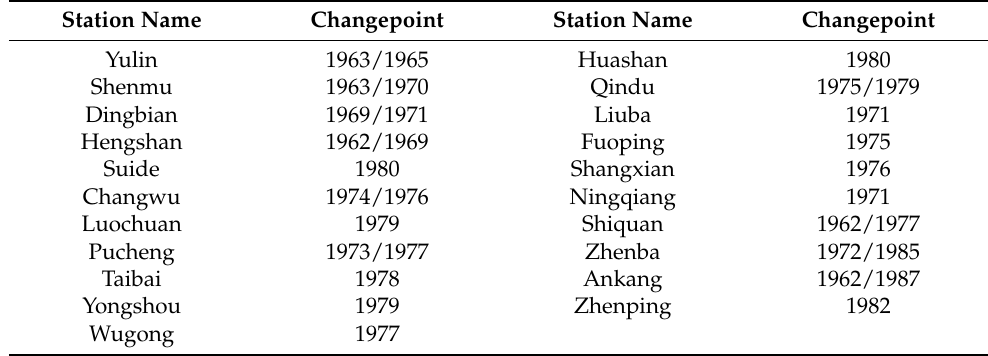
Table 3. Changepoints of PRCPTOT obtained by M–K test.